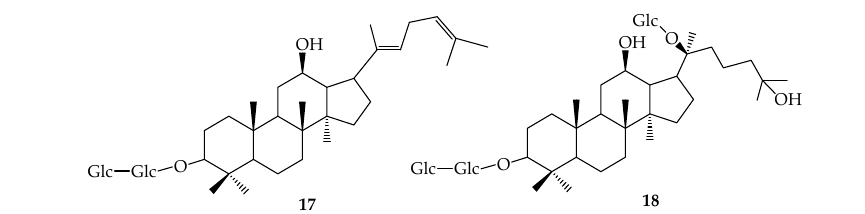
Figure 2. The chemical structures of compound 4 , 5 . Figure 2. The c hemical structures of compound 4 , 5 Figure 2. The c hemical structures of compound 4 , 5